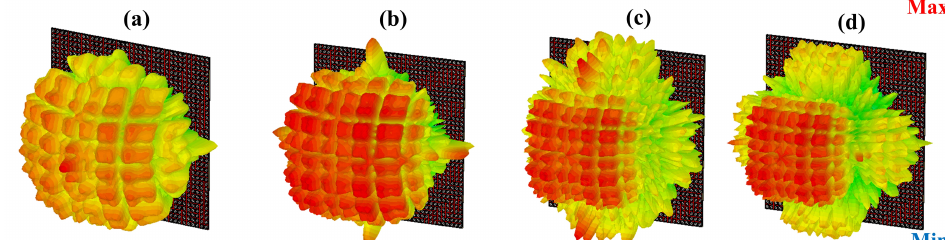
Figure 13. Normalized 3D far-field scattering pattern of a MS1 at ( a ) 12, ( b ) 18, ( c ) 24, and ( d ) 30 GHz.